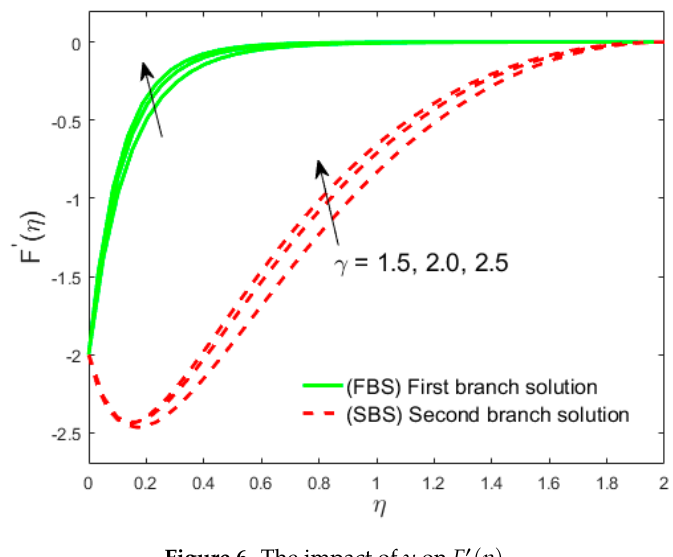
Figure 6. The impact of γ on F (cid:48) ( η ) .